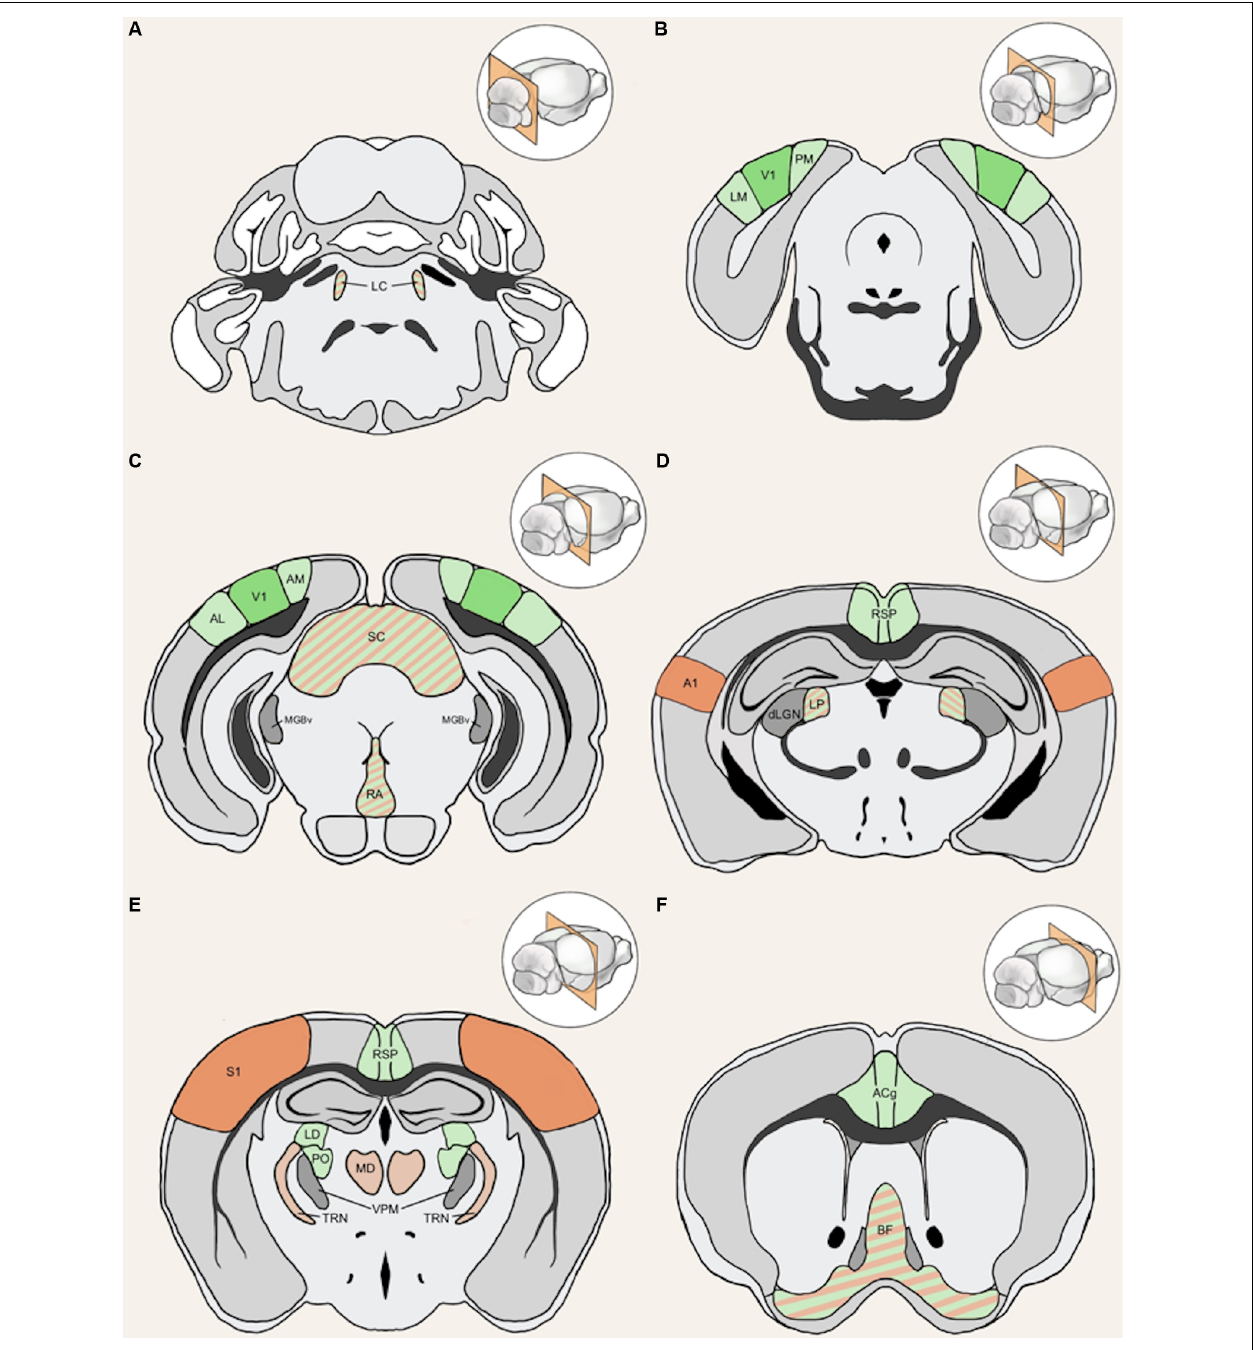
FIGURE 4 | Anatomical structures implicated in cross-modal plasticity induced by vision loss. Six coronal sections of a mouse brain are listed in order from posterior to anterior. Structures involved in cross-modal recruitment are labeled in green (V1, LM, PM, AM, AL, RSP, ACg, LD, PO), structures involved in compensatory plasticity are labeled in orange (A1, S1, MD, TRN), and those involved in both are labeled with stripes of green and orange (LC, superior colliculus (SC), RA, LP, BF). Darker shades (V1, A1, S1) represent cortical structures that have been experimentally demonstrated to undergo plasticity with visual deprivation, while lighter shades are tentative structures implicated in the plasticity. Primary sensory thalamic nuclei are labeled in gray (dLGN, MGBv, VPM). Inset in each panel shows the location of the coronal section plane. (A) The locus coeruleus (LC) contains the cell bodies of most norepinephrine expressing neurons. These cells send vast projections across cortical areas and are involved in both attention and arousal. Following vision loss, the increased salience of auditory and somatosensory cues might be conveyed through norepinephrine projections, facilitating potentiation in spared sensory cortices (compensatory plasticity) as well as potentiation of spared inputs into V1 (cross-modal recruitment). The relative concentration of norepinephrine is thought to play a role in determining the polarity spike-timing-dependent